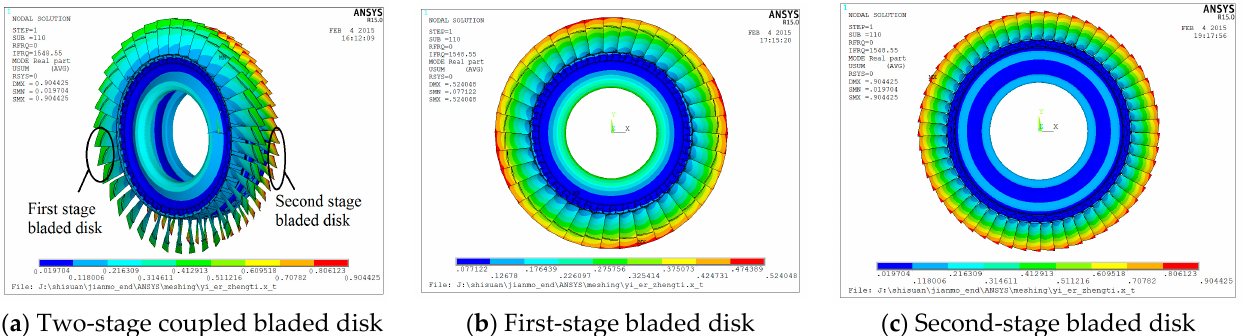
Figure 26. Coupled vibration at a 674.13 Hz natural frequency.